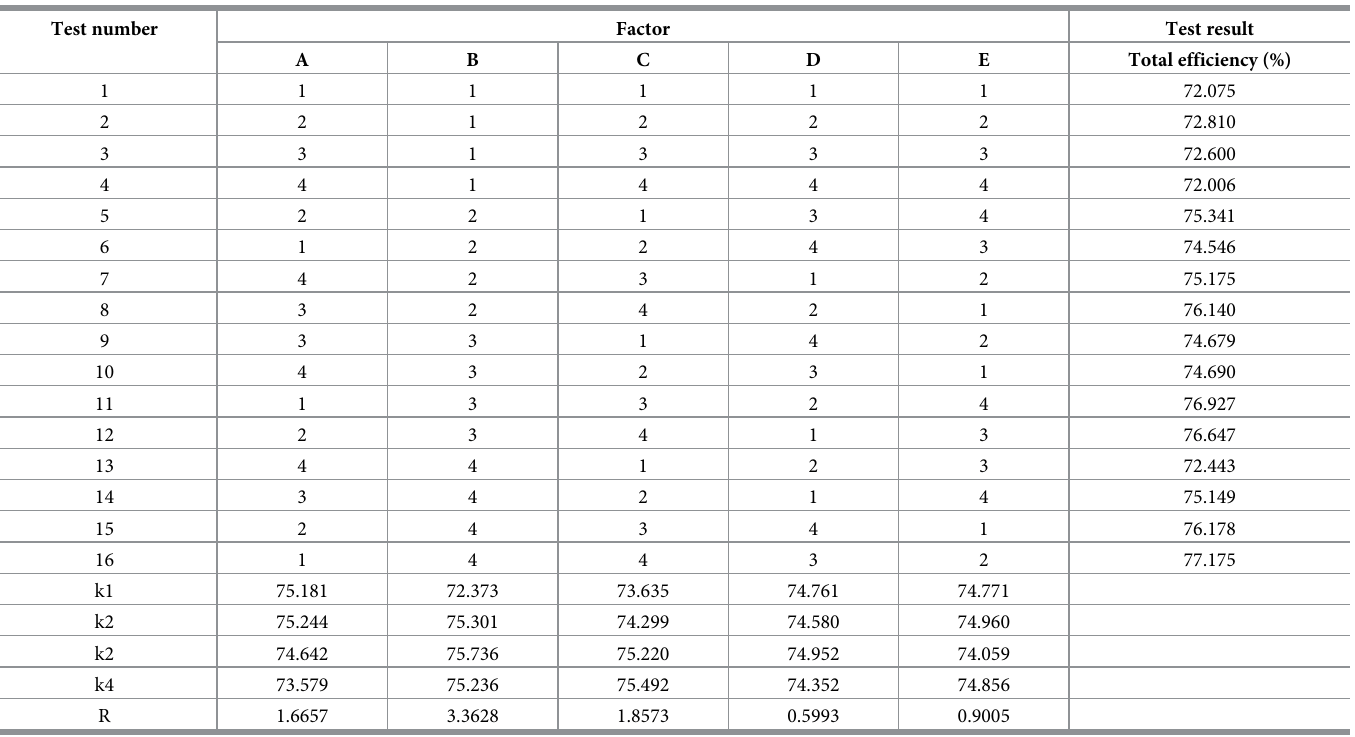
Table 12. Orthogonal test analysis table of total